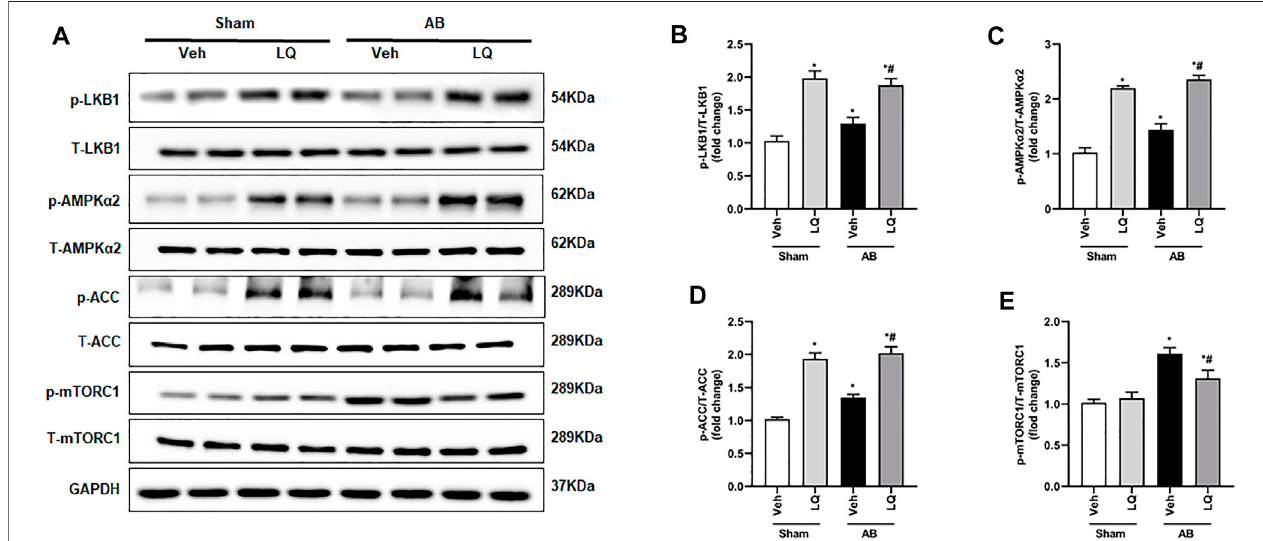
FIGURE 5 | Liquiritin activates the LKB1/AMPK α /ACC/mTORC1 signaling pathway in the myocardium. (A) Representative immunoblots for phosphorylated LKB1 (p-LKB1),totalLKB1(T-LBK1),p-AMPK α 2,T-AMPK α 2,p-Acetyl-CoAcarboxylase(p-ACC),T-ACC,p-mTORC1,andT-mTORC1.Relativeexpressionof (B) p-LKB1/T-LKB1,